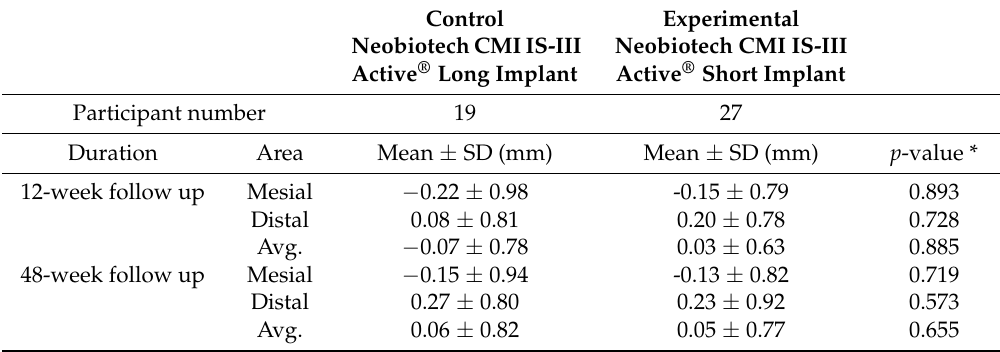
Table 3. Comparison of marginal bone loss between the long and short